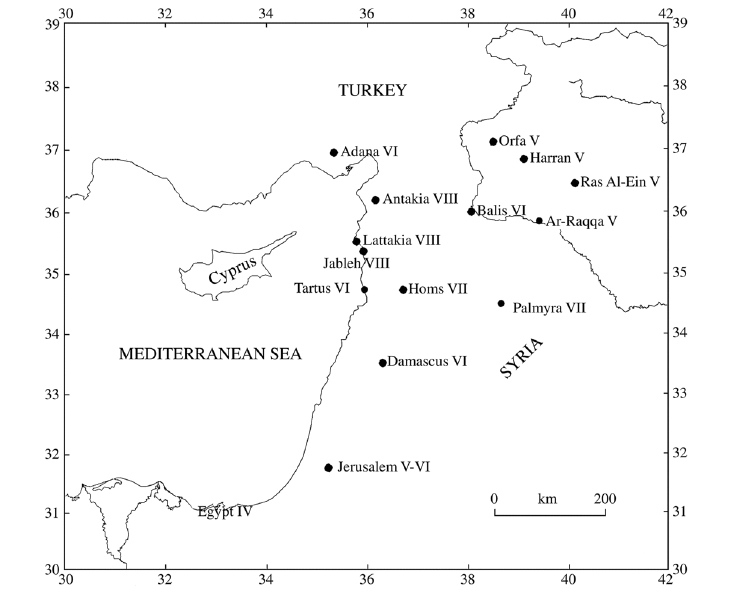
Fig. 6. Map of intensity distribution for the December 859-January 860 A.D.